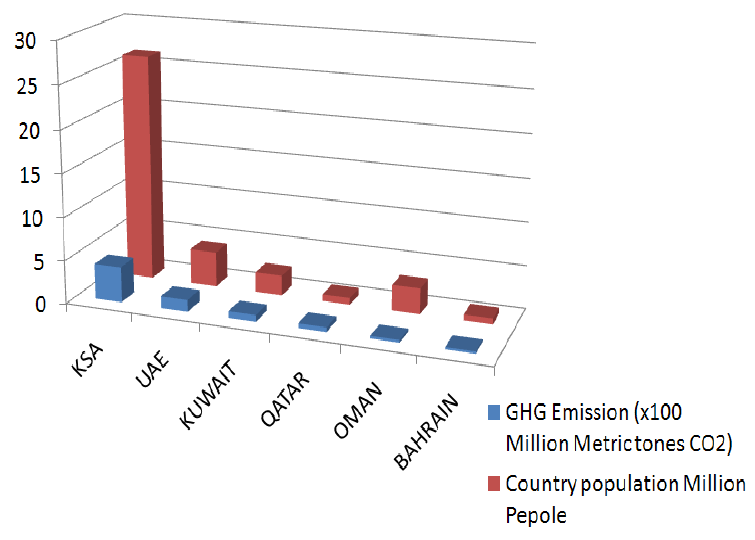
Figure 7. Pro-capite Electricity consumption and GHG